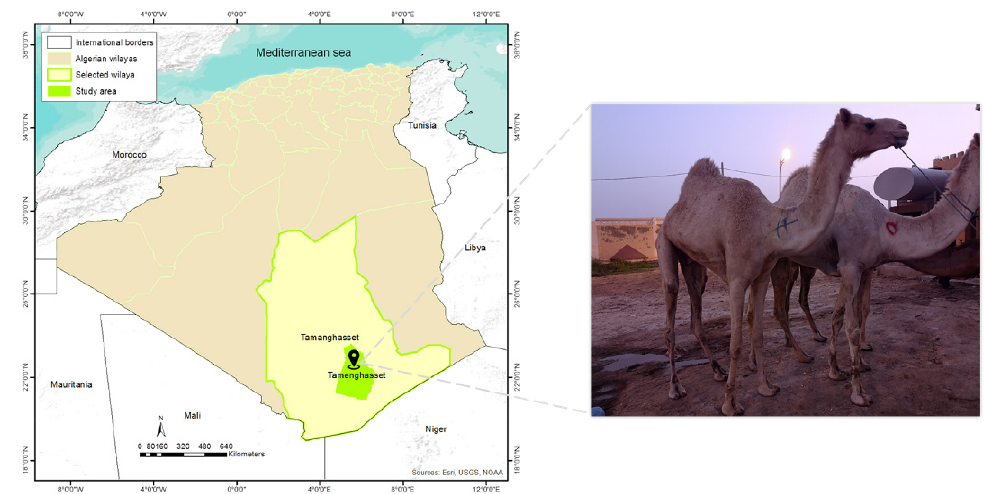
Figure 1. Map of Algeria showing the location of tick collection (Tamanrasset) and the examined dromedary camels. ArcGIS 10.3 software (http://www.esri.com, accessed on 25 October 2021). ArcGIS 10.3 software (http://www.esri.com, accessed on 25 October 2021) was used to map the spatial localization of tick sampling in our study region.